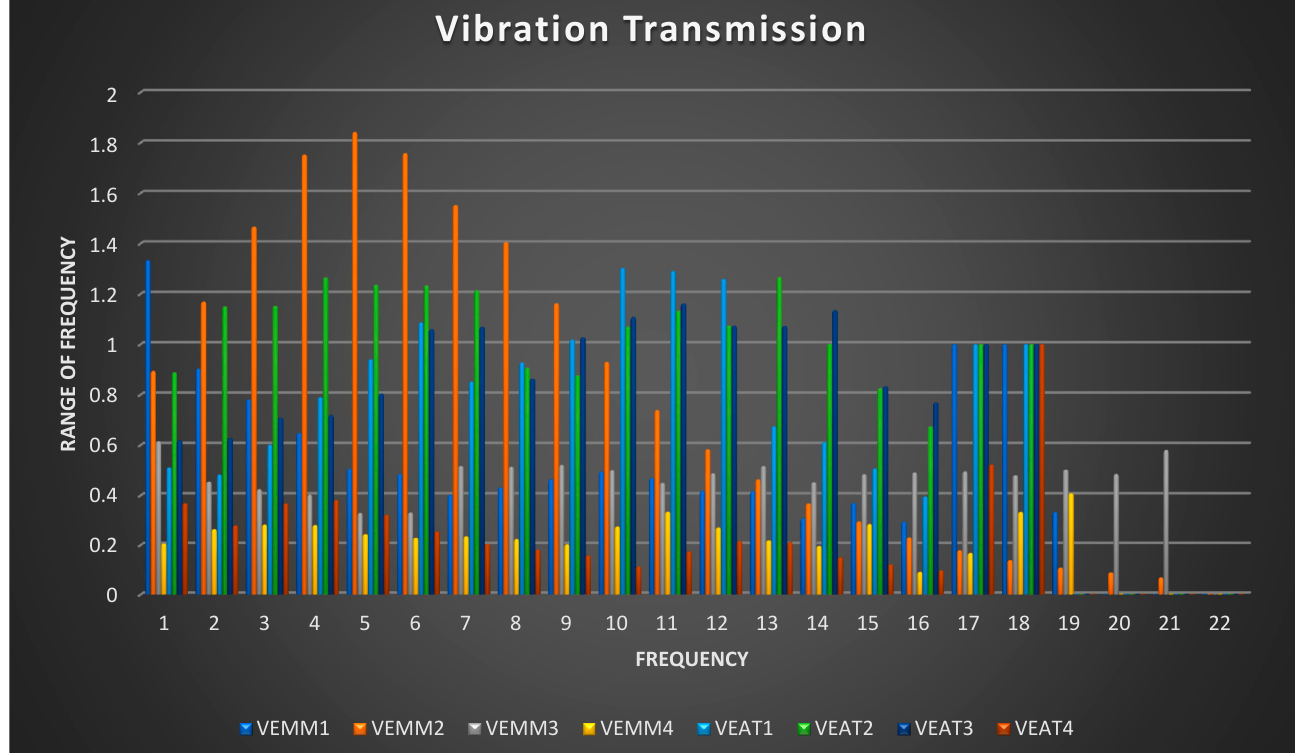
Figure 4. Showing 1/3rd-octave band average vibration transmission. The resonance frequency range of vibration transmissibility for both used and new hand pieces (for both MMs and ATs) in a majority of the cases is less than unity. Hence, it shows that most dental professionals’ vibrations were absorbed through their fingers, palms, and hands. The lower the transmissibility range, the higher the absorption by the limbs of the dental workers. The statistical testing technique consisted of each hand piece average transmission with three transmission points for all the 22 frequencies. The descriptive statistics of average vibration transmissions were calculated and are shown in Table 10. Table 10. Descriptive statistics of 1/3 octave band vibration transmissions of hand pieces.